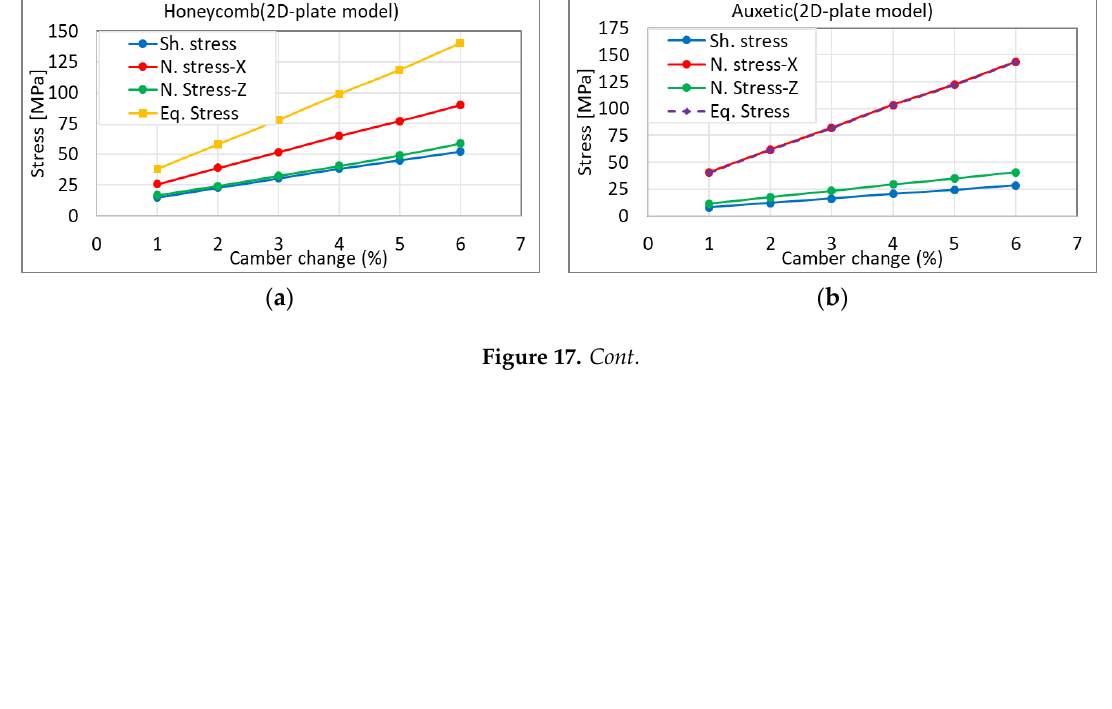
Figure 16. ( a ) In-plane shear stress/strain curve and ( b ) percentage of camber change vs. corresponding strain.